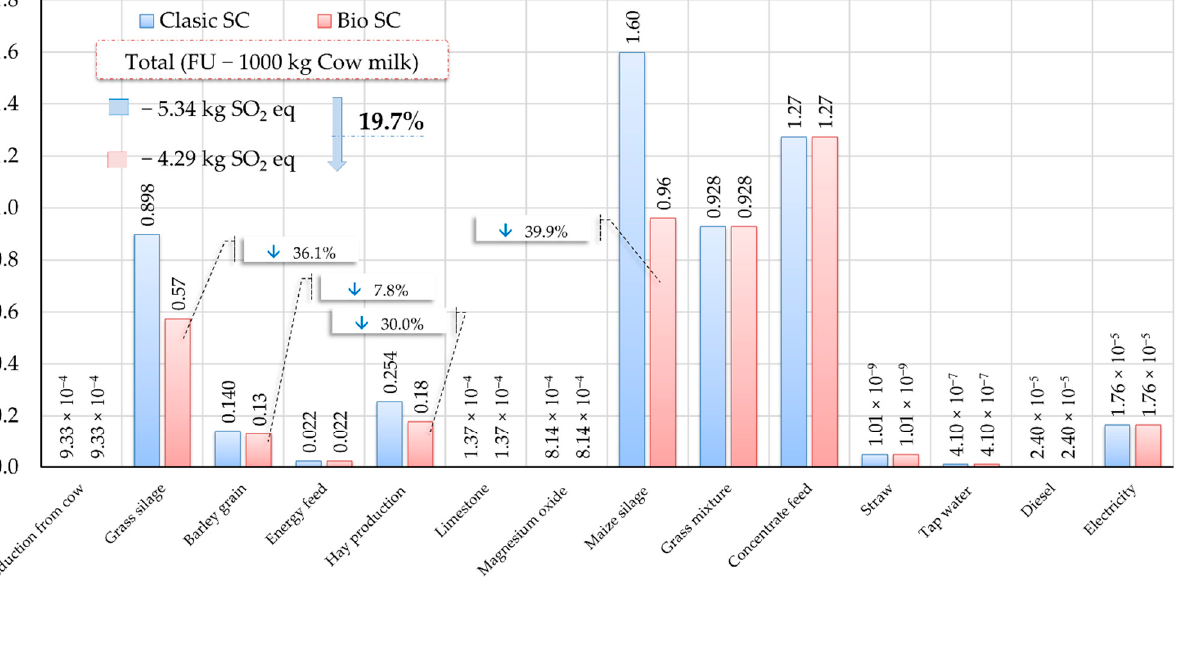
Figure 5. TAP of milk production stocks per FU.